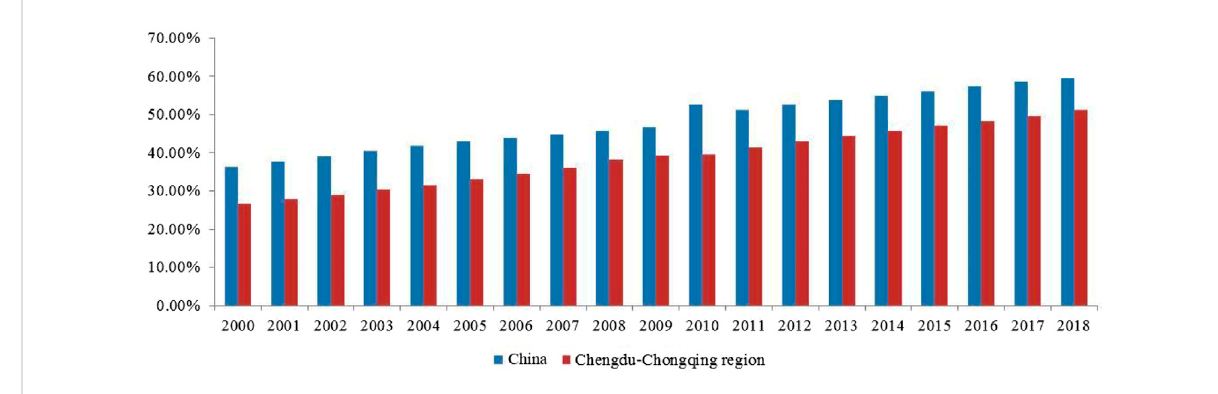
FIGURE 3 Urbanization rate in the Chengdu-Chongqing region, 2000 – 2018.